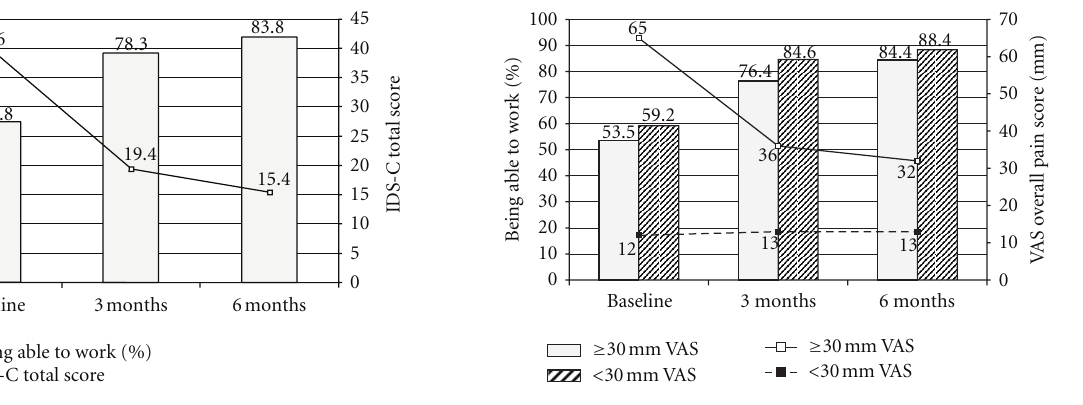
Figure 3: Subgroup analysis by baseline pain severity ( < 30mm VAS versus ≥ 30 mm VAS) for % patients being able to work and mean VAS overall pain score at baseline, 3 months and 6